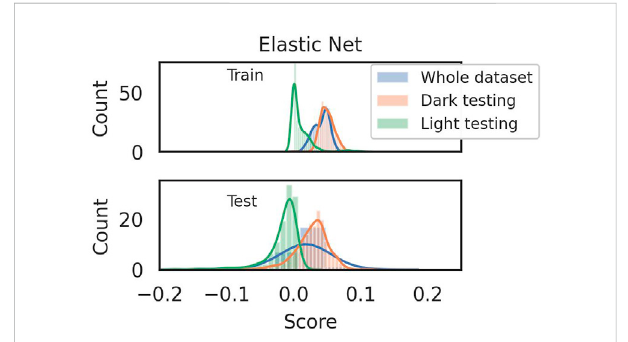
FIGURE 6 Train and test score for Elastic Net on the three dataset splits. Both quantities for the three splits are very low.